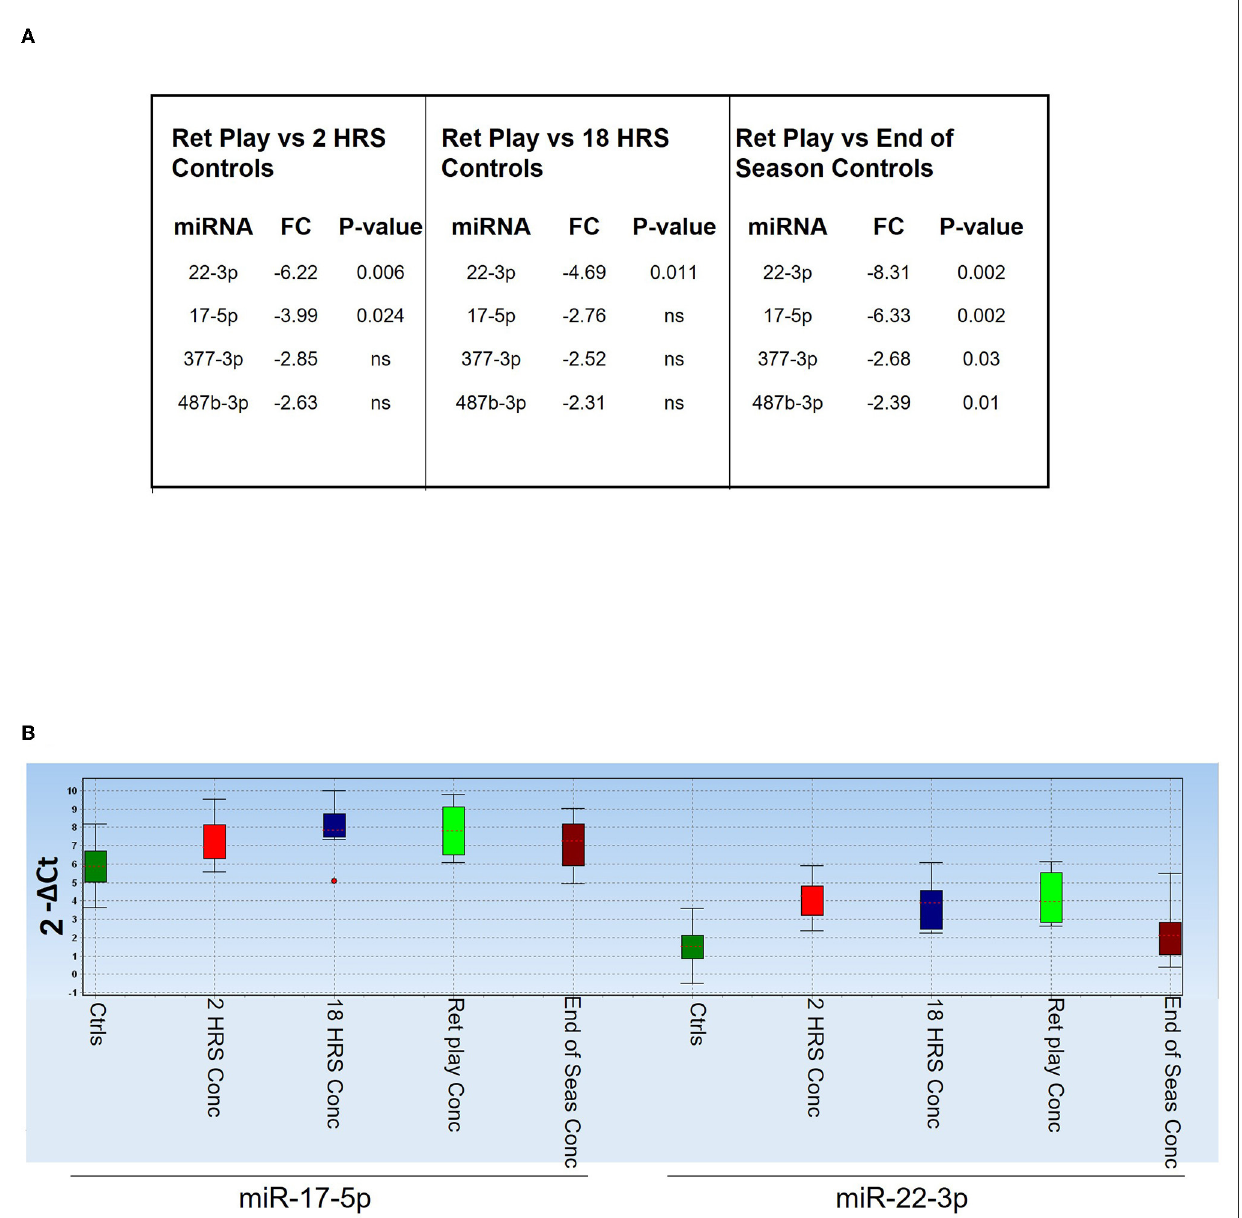
FIGURE6 Diagnostic value of miR-17-5p and miR-22-3p. (A) Table showing miRNAs that discriminated players returned to the field after concussion ( n = 5) from controls [overall ( n = 29), 2h ( n = 11), 18h ( n = 9), and End of the Season ( n = 9)]. P -values are indicated; ns means non-statistically significant. FC: fold change expressed as 2 − 11 Ct . (B) Expression levels of miR-17-5p and miR-22-3p in the indicated groups of players, measured as 2 − 1 Ct . The dot indicates an